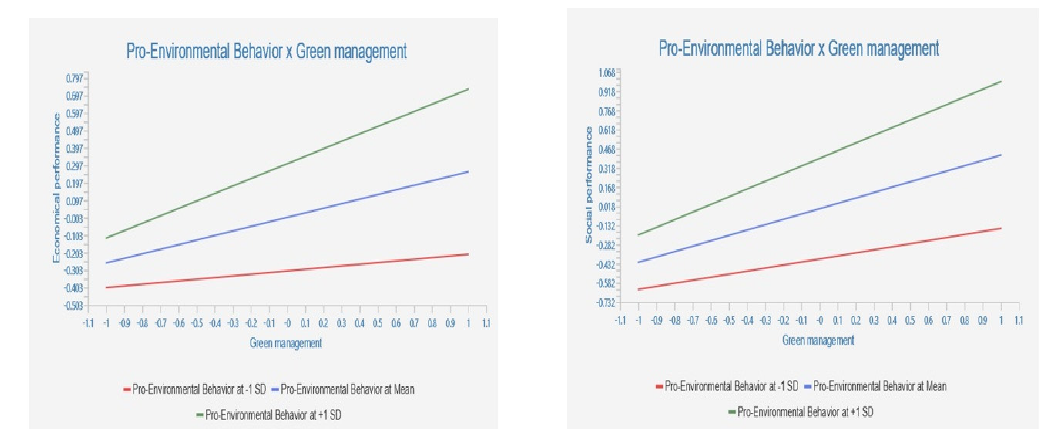
Figure 4. Simple Slope analysis for the moderating effects.